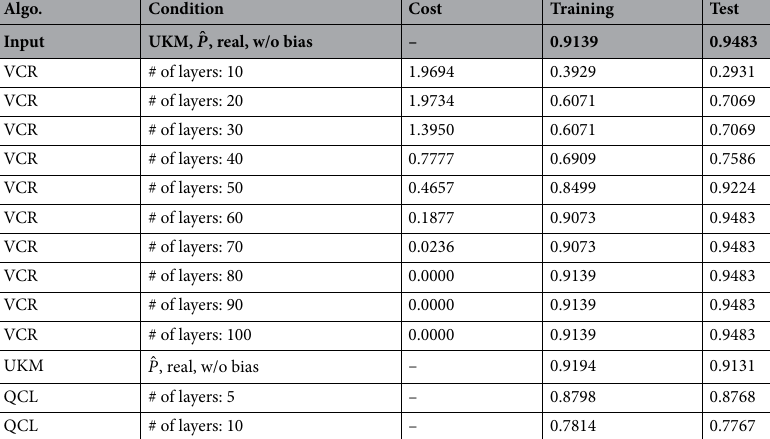
Table 5. Performance of the VCR for the cancer dataset (0 or 1). We show the success rates for the training and test datasets and the value of the cost function for the VCR. The input for the VCR is ˆ P created by the UKM under the condition of real matrices without the bias term with r = 0.010 . For reference, we add the last three rows that show the results of 5-fold CV. The table shows that around 50 layers, by combining the UKM with the VCR one can get a better performance than that of